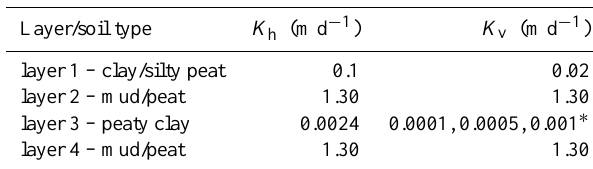
Table 3. Horizontal and vertical hydraulic conductivities for the model layers representing the